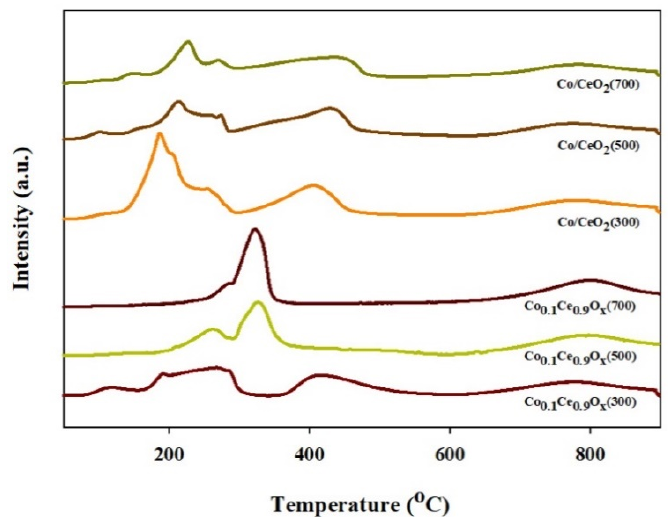
Figure 1. H 2 -TPR patterns of ceria-supported cobalt catalysts calcined in air at different temperatures.